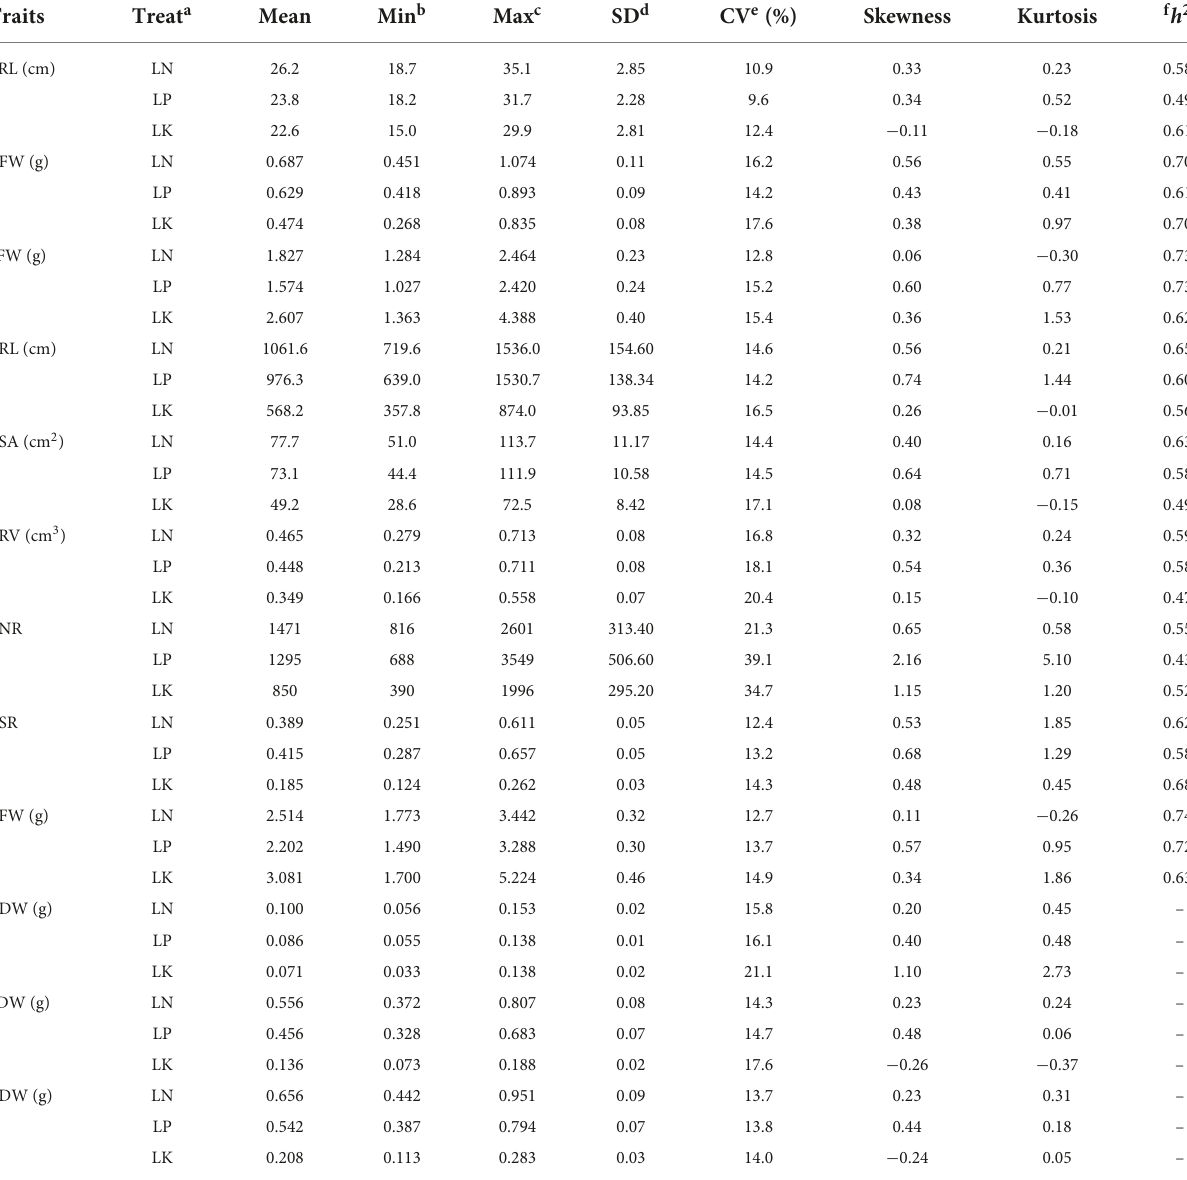
TABLE 1 Descriptive statistics for investigated traits under NPK-stress in the recombinant inbred line (RIL) population.